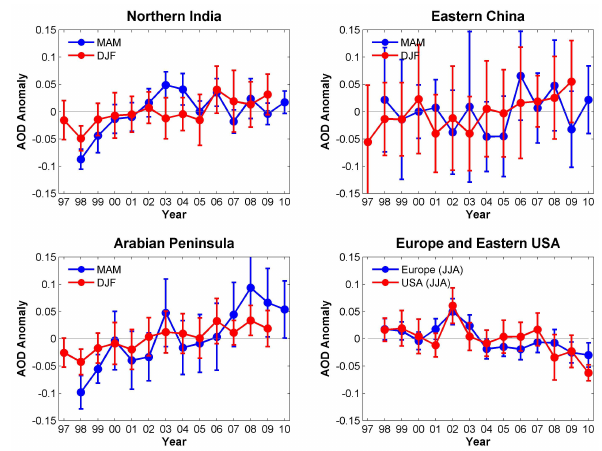
Fig. 12. SeaWiFS time series of seasonal averaged AOD anomaly over northern India (20–30 ◦ N, 75–85 ◦ E), eastern China (30– 40 ◦ N, 110–120 ◦ E), Arabian Peninsula (10–35 ◦ N, 35–60 ◦ E), Eu- rope (43–55 ◦ N, 0–30 ◦ E), and eastern United States (30–45 ◦ N, 70–90 ◦ W). The vertical bars denote the ±1 standard deviation of seasonal averaged AOD anomaly within the specified